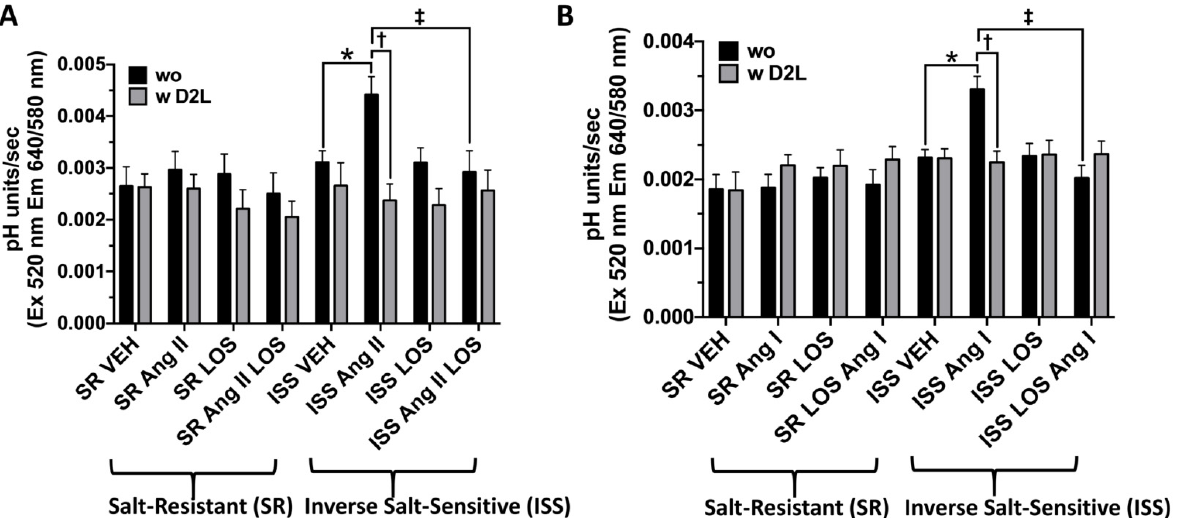
Figure 6. pH recovery in SR and ISS cells under Ang II and Ang I treatments. SR and ISS uRPTCs were plated in 96-well plates incubated in 90 mmol/L NaCl, osmolality adjusted to 290 with mannitol, labeled with SNARF1 pH indicator, acidified with ammonium chloride (20 mmol/L, 10 min), switched to sodium-free media (290 osmolality/mannitol) with or without angiotensin II (Ang II, ( A )) or angiotensin I (Ang I, ( B )) (10 nmol/L), for 5 min with or without the addition of the AT 1 R antagonist, losartan (LOS, 1 µmol/L, 5 min). pH was measured in a microplate fluorometer using a custom single excitation dual emission filter set every 10 s with pH recovery initiated by low sodium buffer (90 mmol/L Sodium as NaCl) and pH recovery measured as pH units/sec. ( A ) Ang II increases pH recovery in low sodium concentration only in ISS uRPTCs (ISS Ang II 0.0044 ± 0.0003 vs. ISS VEH 0.0031 ± 0.0002, n = 6/group, Two-way ANOVA, Tukey’s test, * p < 0.05) and the AT 1 R antagonist, losartan, LOS completely blocks the response (ISS Ang II 0.0044 ± 0.0003 vs. ISS Ang II LOS 0.0029 ± 0.0004, n = 6/group, Two-way ANOVA, Tukey’s test, ‡ p < 0.05). Stable transfection of DRD2 (wD2L) completely blocks the low sodium Ang II-dependent increase in pH in uRPTCs from individuals with ISS (ISS Ang II 0.0044 ± 0.0003 vs. ISS Ang II w D 2 R 0.0024 ± 0.0003, n = 6/group, Two-way ANOVA, Holm-Sidak test, † p < 0.05). ( B ) The Ang II precursor peptide, Ang I, increases pH recovery in low sodium, only in ISS uRPTCs (ISS Ang I 0.0033 ± 0.0002 vs. ISS VEH 0.0023 ± 0.0001, n = 6/group, Two-way ANOVA, Tukey’s test, * p < 0.05) and LOS completely blocks the response (ISS Ang I 0.0033 ± 0.0002 vs. ISS Ang I LOS 0.002 ± 0.0002, n = 6/group, Two-way ANOVA, Tukey’s test, ‡ p < 0.05). Stable transfection of DRD2 (wD2L) completely blocks the low sodium Ang I-dependent increase in pH in uRPTCs from individuals with ISS (ISS Ang I 0.0033 ± 0.0002 vs. ISS Ang I w D 2 R 0.0022 ± 0.0002, n = 6/group, Two-way ANOVA, Holm-Sidak test, † p < 0.05). wo (non DRD2 -transfected uRPTCs), wD2L ( DRD2 Long-transfected uRPTCs). ISS = inverse salt-sensitive; SR =